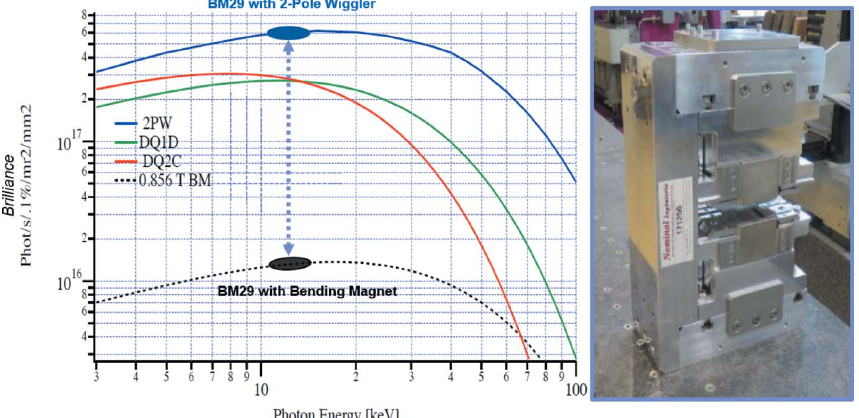
Figure 1 Increase in brilliance between BM29’s original bending magnet and current two-pole wiggler sources (photograph shown in inset). DQ2C and DQ1D correspond to combined dipole– quadrupole magnets located upstream and downstream, respectively, of the 2PW source in the ESRF–EBS